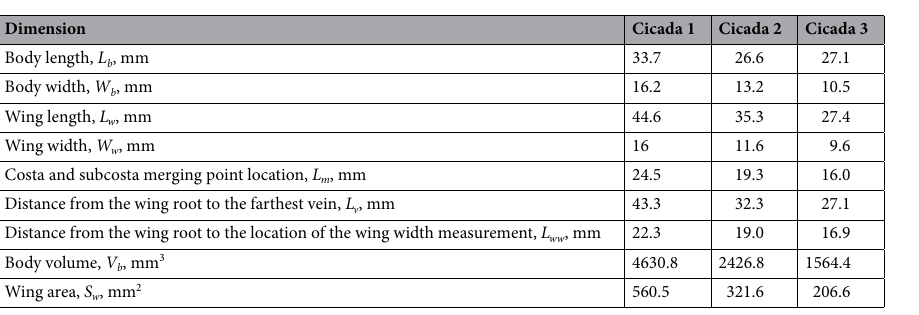
Table 1. Cicada wing and body